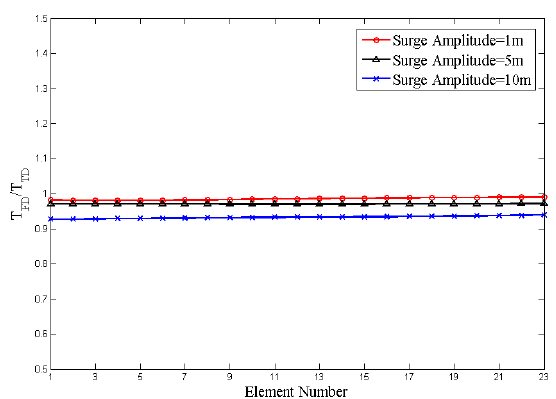
Figure 13. The ratio of dynamic tension amplitude in the frequency domain and time domain under harmonic excitation.